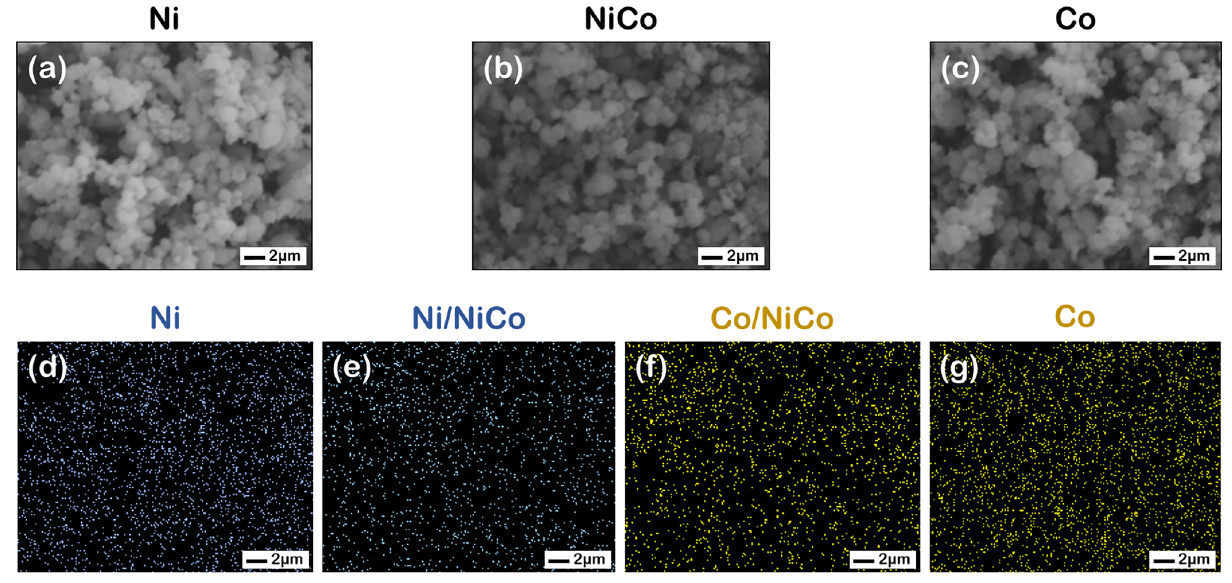
Figure 1. SEM profiles of ( a ) Ni catalyst, ( b ) NiCo-50:50 NiCo catalyst, and ( c ) Co catalyst and SEM–EDX profiles of ( d ) Ni elemental mapping in Ni catalyst, ( e ) Ni and ( f ) Co elemental mapping of NiCo-50:50 NiCo catalyst, and ( g ) Co elemental mapping in the Co catalyst. Note that the blue and yellow dots represent Ni and Co elemental mapping, respectively.